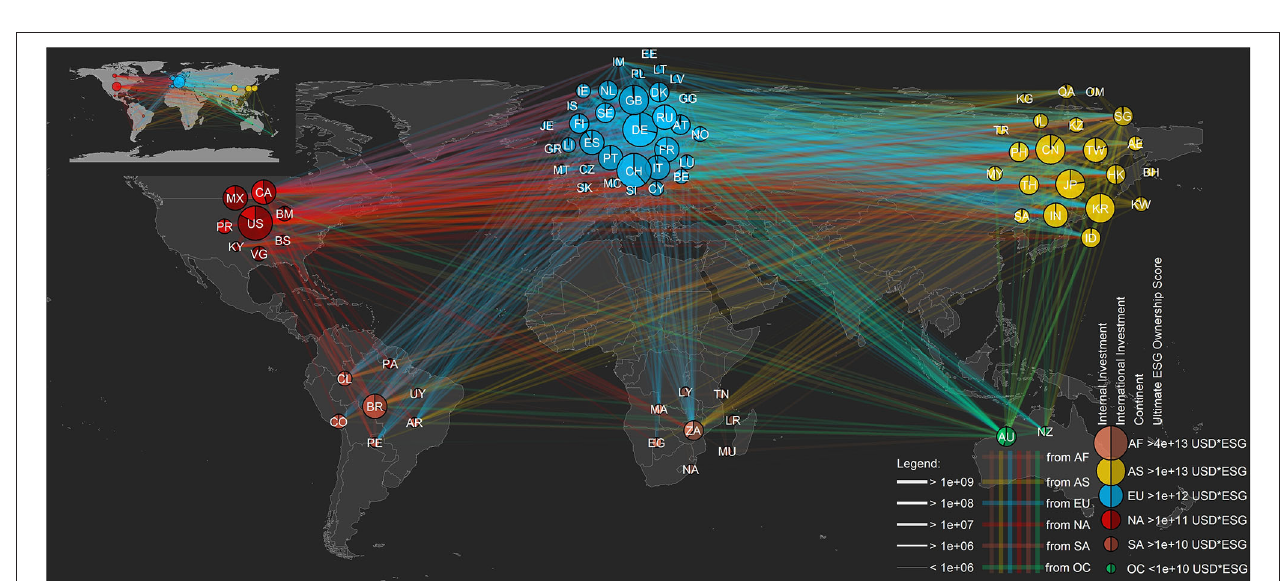
FIGURE 2 | ESG ownership country-level network